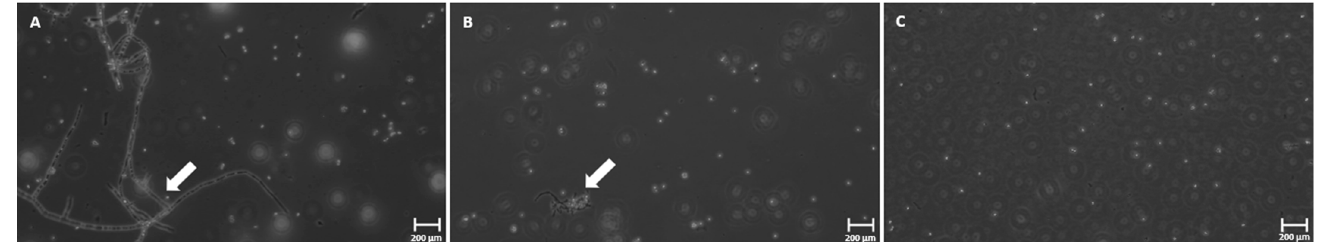
Figure 2. Phase-contrast microscopy images (20× magnification) of the commercial apple juice inoculated with B. nivea ascospores in unpasteurized samples stored for 30 days at atmospheric pressure (AP) at room temperature (RT) ( A ), under refrigeration at 4 °C ( B ) and under hyperbaric storage at 150 MPa at RT ( C ). The white arrow highlights hyphae formation.